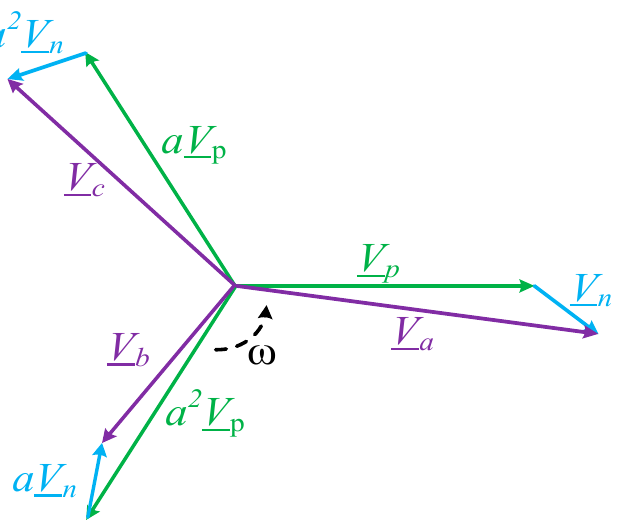
Figure 5. Phasor diagram of the resultant voltage from its sequence components .